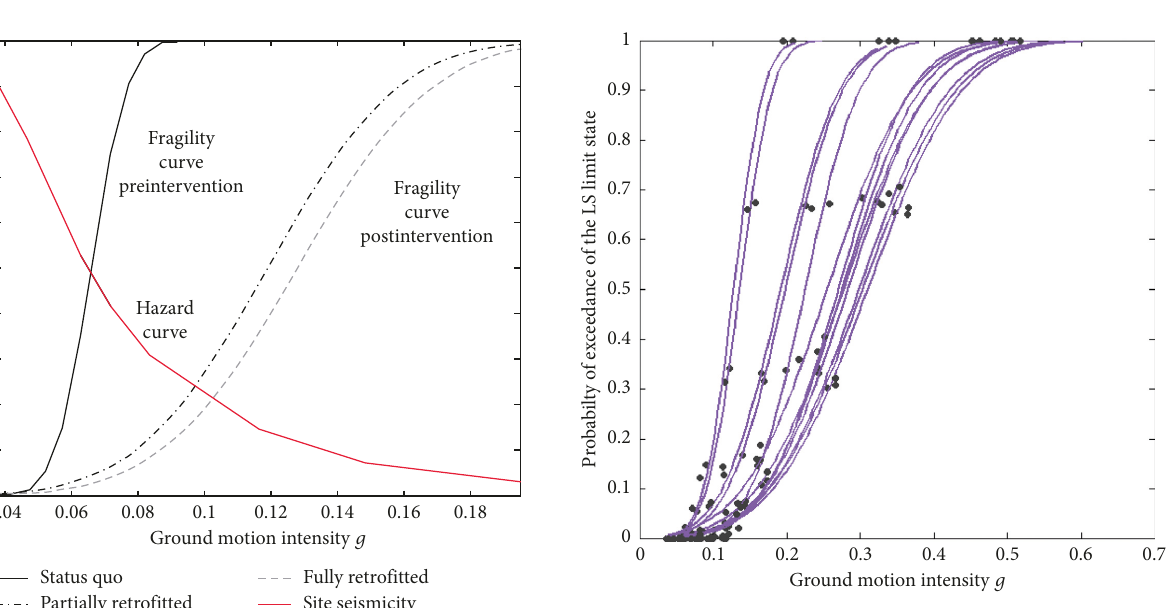
Figure 13: Fitted fragility curves for cases that could be structurally upgraded by full retrofitting. Figure 11: Hazard curve and pre- and postintervention fragilities